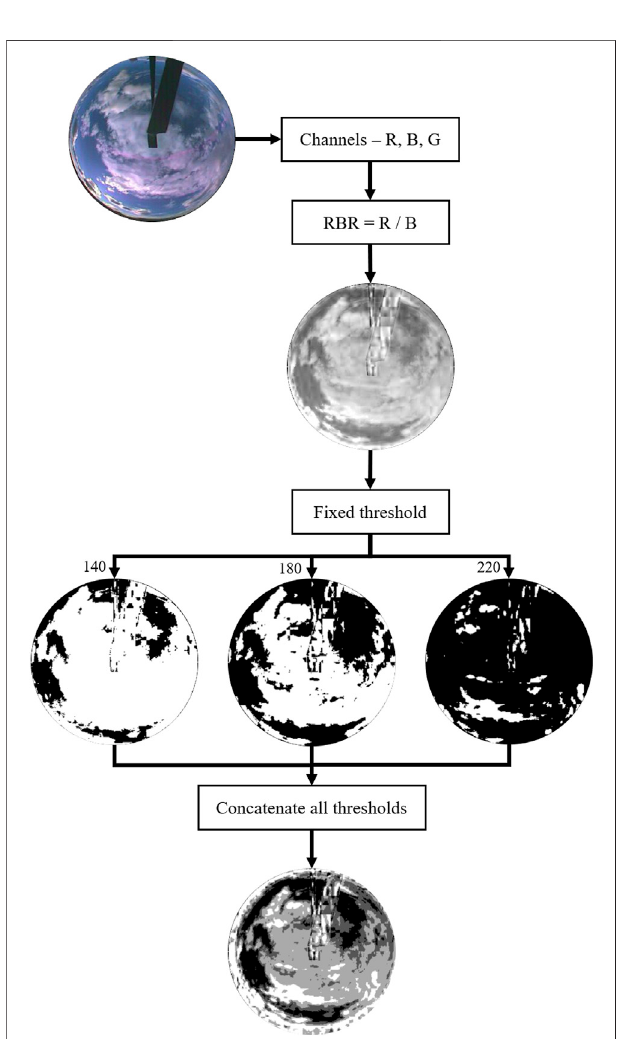
FIGURE 4 | Cloud detection using the Red Blue Ratio